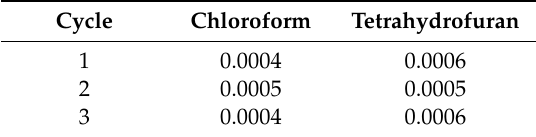
Table 5. Sensitivity α (ppm − 1 ) of the sensor to THF and CHCl 3 . Standard deviation of 0.0001 for all